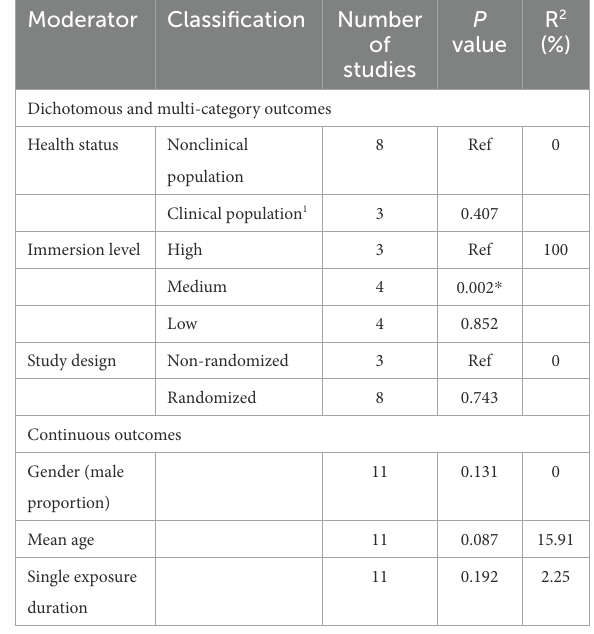
TABLE 3 Summary meta-regression results table.